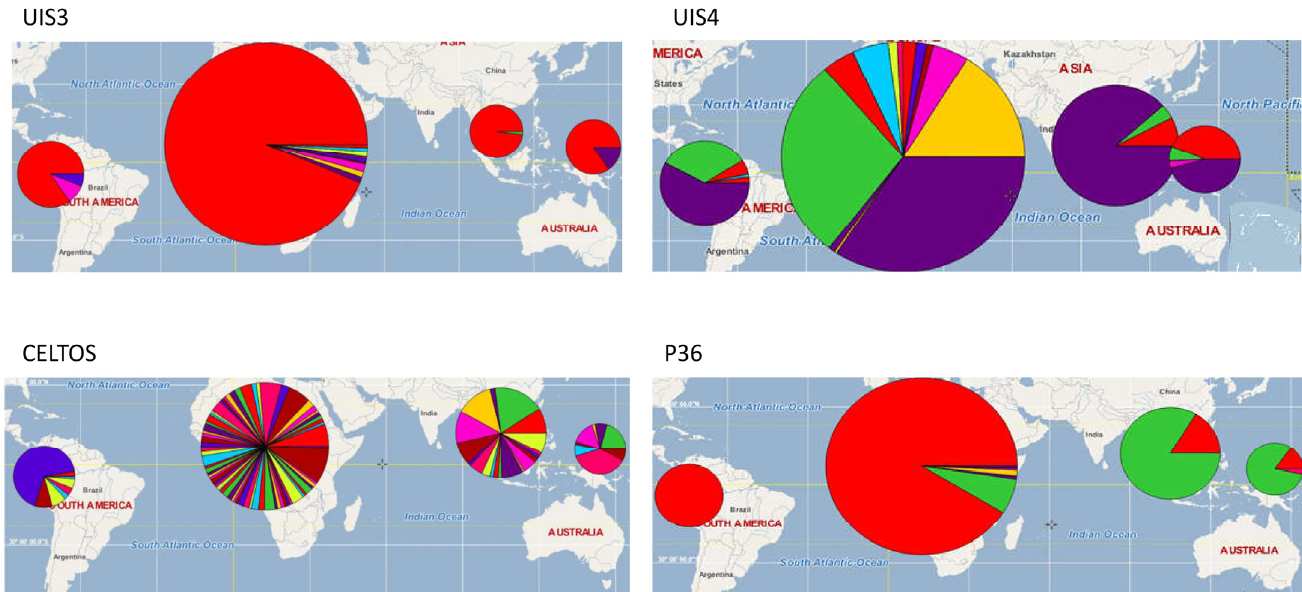
Figure 1. Worldwide distribution of amino acid sequences of four malaria vaccine candidates. Panel A represents haplotypes for upregulated-in-infectious-sporozoites 3 (UIS3), while panel B shows the worldwide distribution of UIS4 sequences. Panel C represents P36 sequences, and panel D is a world map view of the distribution of sequences of the cell-traversal protein for ookinetes and sporozoites (CelTOS). The size of the pie is proportional to the sample size used, and each slice of the pie represents a haplotype with color consistency across panels. CelTOS is the most diverse protein, while P36 is the most conserved. Whereas the major haplotype of UIS3 is consistent across continents, the major haplotype of P36 in Africa is the minor haplotype in other continents.